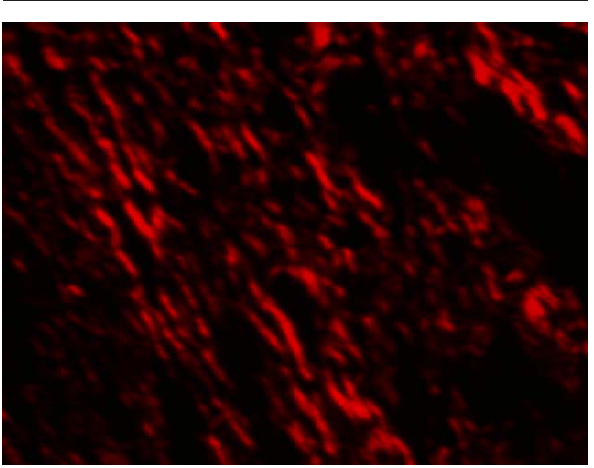
FIGURA 1 – Imagem de corte histológico da área de anastomose em animal do grupo An, corado pelo picro sirius red e observado com filtros analisador e polarizador (200x).